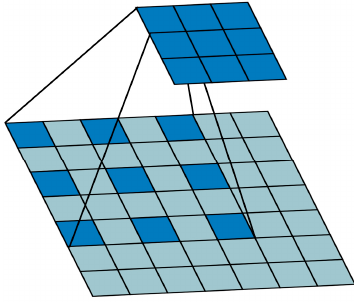
Table 1. Anchor box size